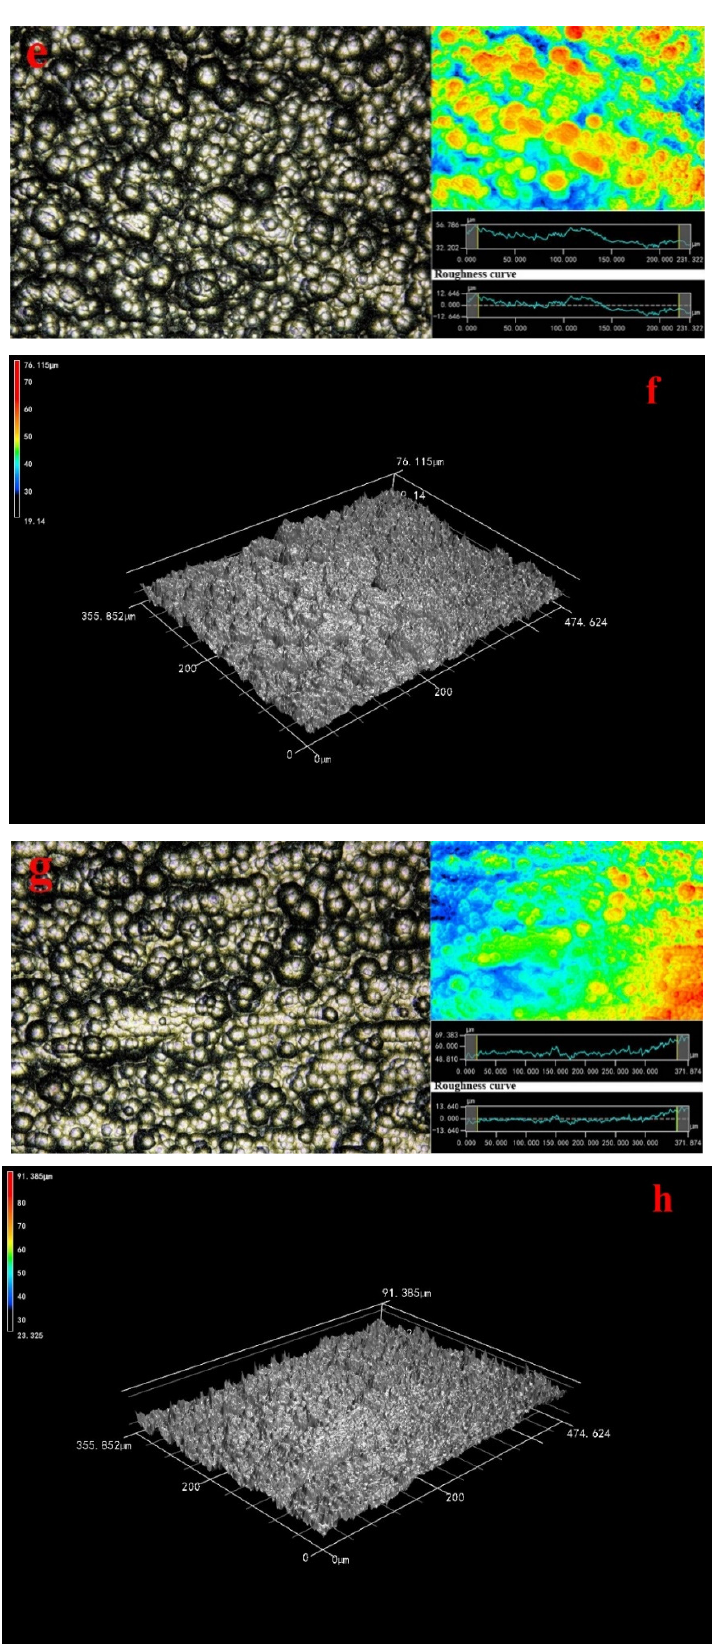
Figure 1. Morphology of composite coatings 200 × ( a ) 4-0; ( b ) 3D image; ( c ) 2-4; ( d ) 3D image; ( e ) 3-4; ( f ) 3D image; ( g ) 4-4; ( h ) 3D image, inset shows a roughness image and surface laser image.